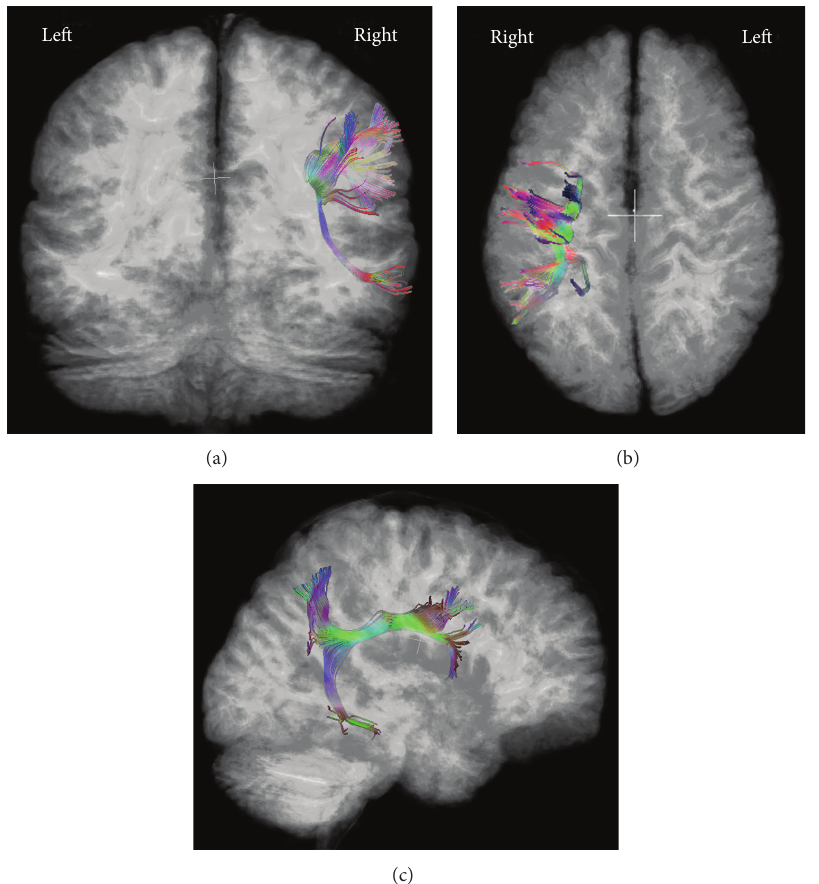
Figure 2: Posterior (a), superior (b), and right-lateral (c) views of a 3-dimensional tract reconstruction of the arcuate fasciculus (AF) in a patient with polymicrogyria (same patient as Figure 1). Images demonstrate presence of the AF in the right hemisphere only. This patient exhibited mild-to-moderate language